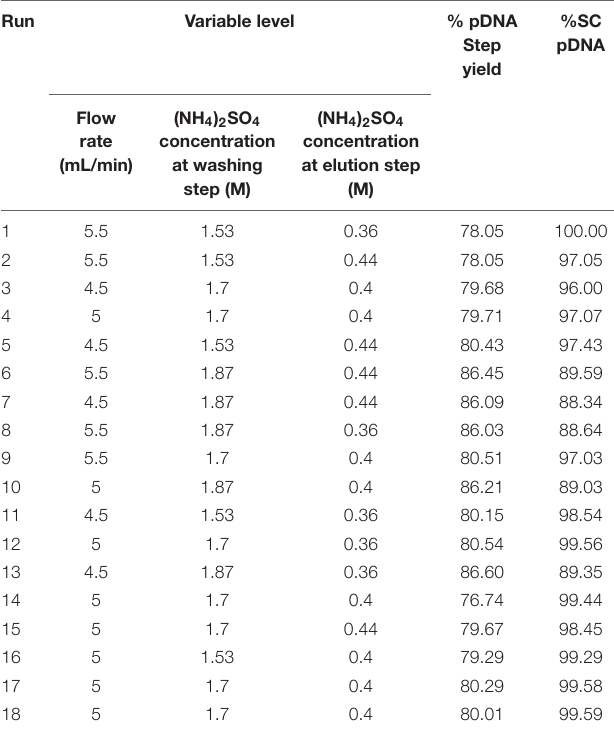
TABLE 1 | Central composite face centered (CCF) and experimental data